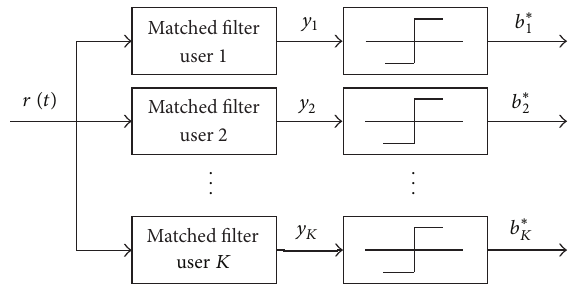
Figure 1: Matched filter part in the